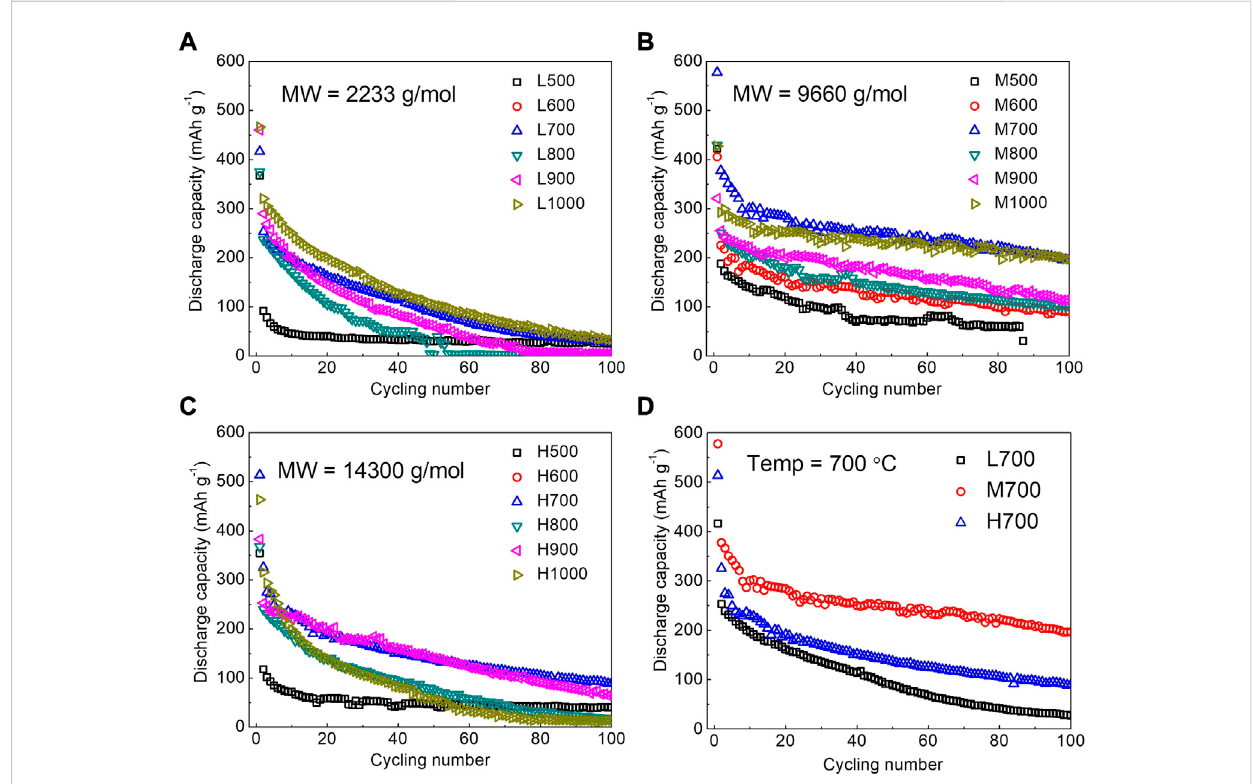
FIGURE 2 Cyclingperformance ofL-HCS (A) ,M-HCS (B) , andH-HCS (C) atpyrolysistemperatures rangingfrom 500 ° C to1,000 ° C,L700, M700,andH700 (D) . All samples were measured at a current density of 50 mA · g − 1 (Wu et al., 2022).